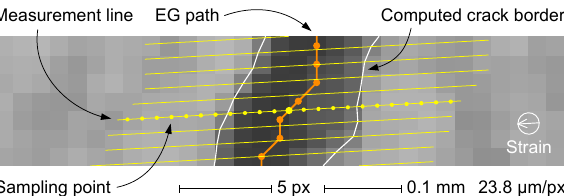
Figure 13. EG-driven crack width determination on the original grayscale image with parallel measurement lines along the strain direction. Measurement lines (yellow) shown here are very short for the sake of clarity (typical sampling point count > 200). The center of each measurement line (thicker yellow dot) is located at the intersection with the crack EG path (orange). The distance between sampling points (yellow dots) and between measurement lines is 0.8 pixel.